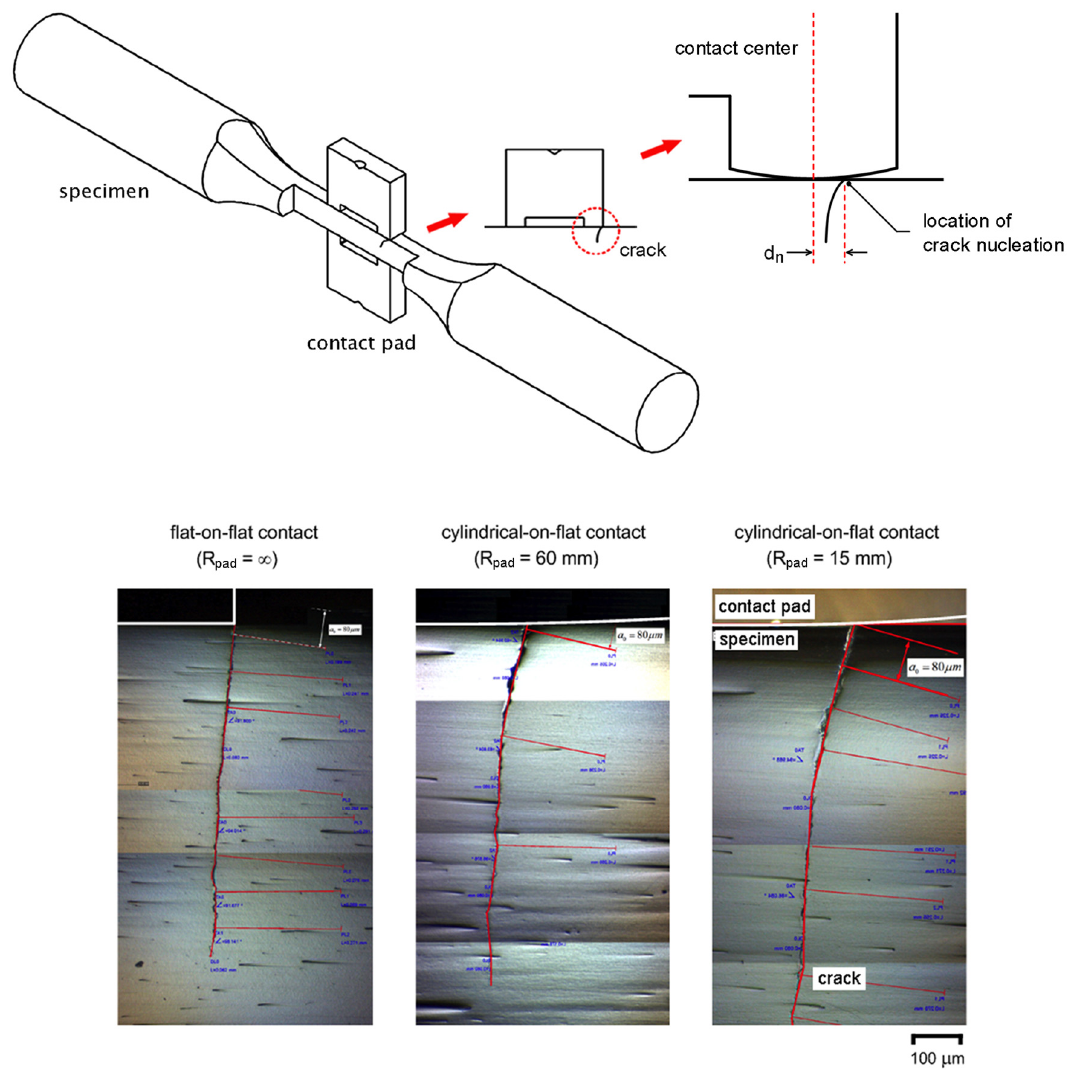
Figure 4. Fretting fatigue cracks tested at a stress amplitude of 300 MPa.